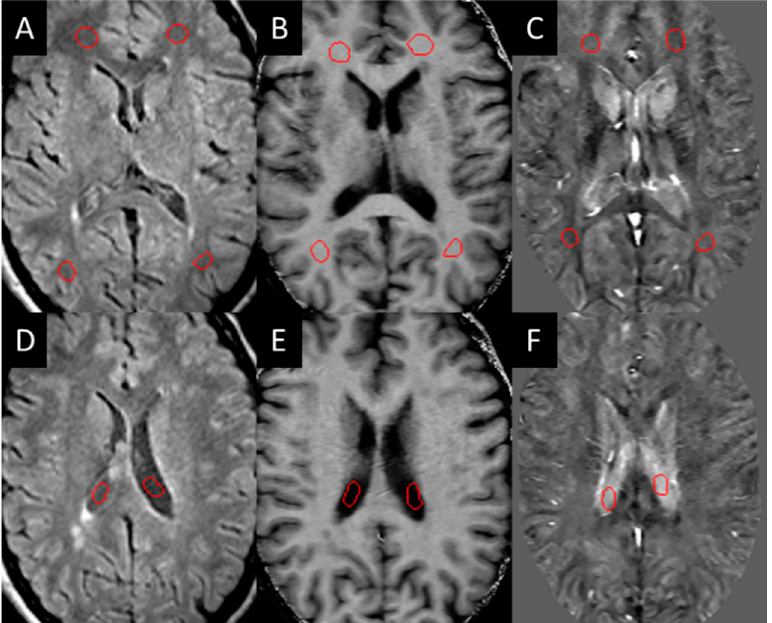
Figure 1. Example of NAWM ROIs (red circles in A – C ) drawn on the white matter and in the CSF (red circles in D – F ) for test re-test reliability: ( A , D ) T2 FLAIR, ( B , E ) MTR, ( C , F ) iSWIM. The T2W and T2 FLAIR lesions that were observed but lacked contrast in the QSM and SWI phase were then drawn separately and classified as QSM-negative (QSM − )